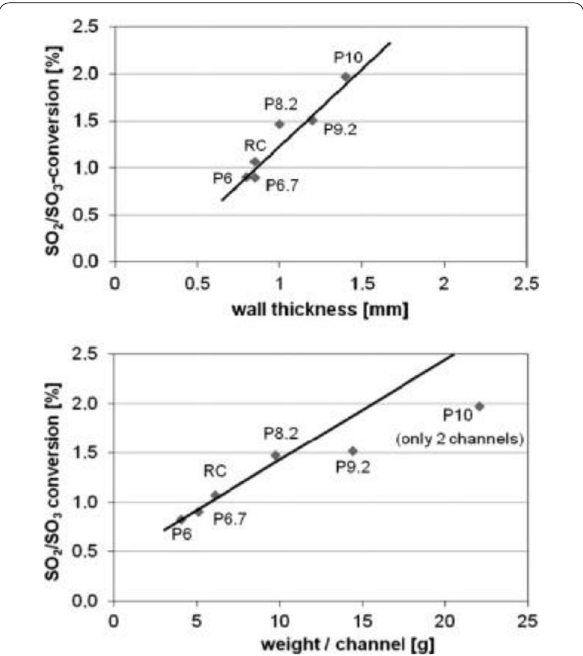
Fig. 12 Correlations between catalyst wall thickness and channel weight and SO